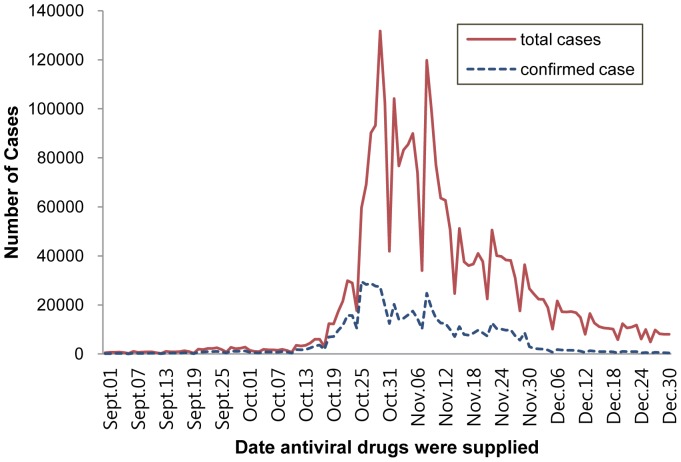
Number of antiviral drug users in the Antiviral Drug Surveillance System (ADSS) from September to December 2009.The frequency dropped at the time of clinic and pharmacy closings on Sundays.